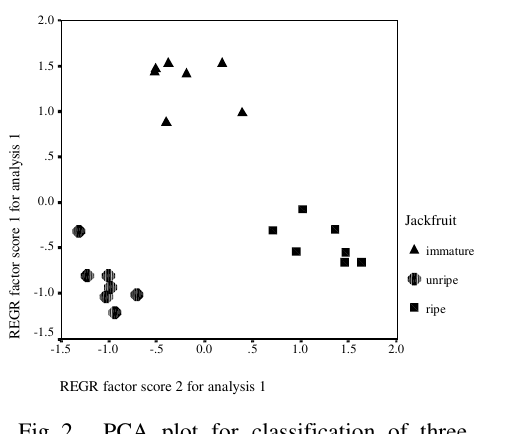
Fig. 2. PCA plot for classification of three maturity stages of jackfruit